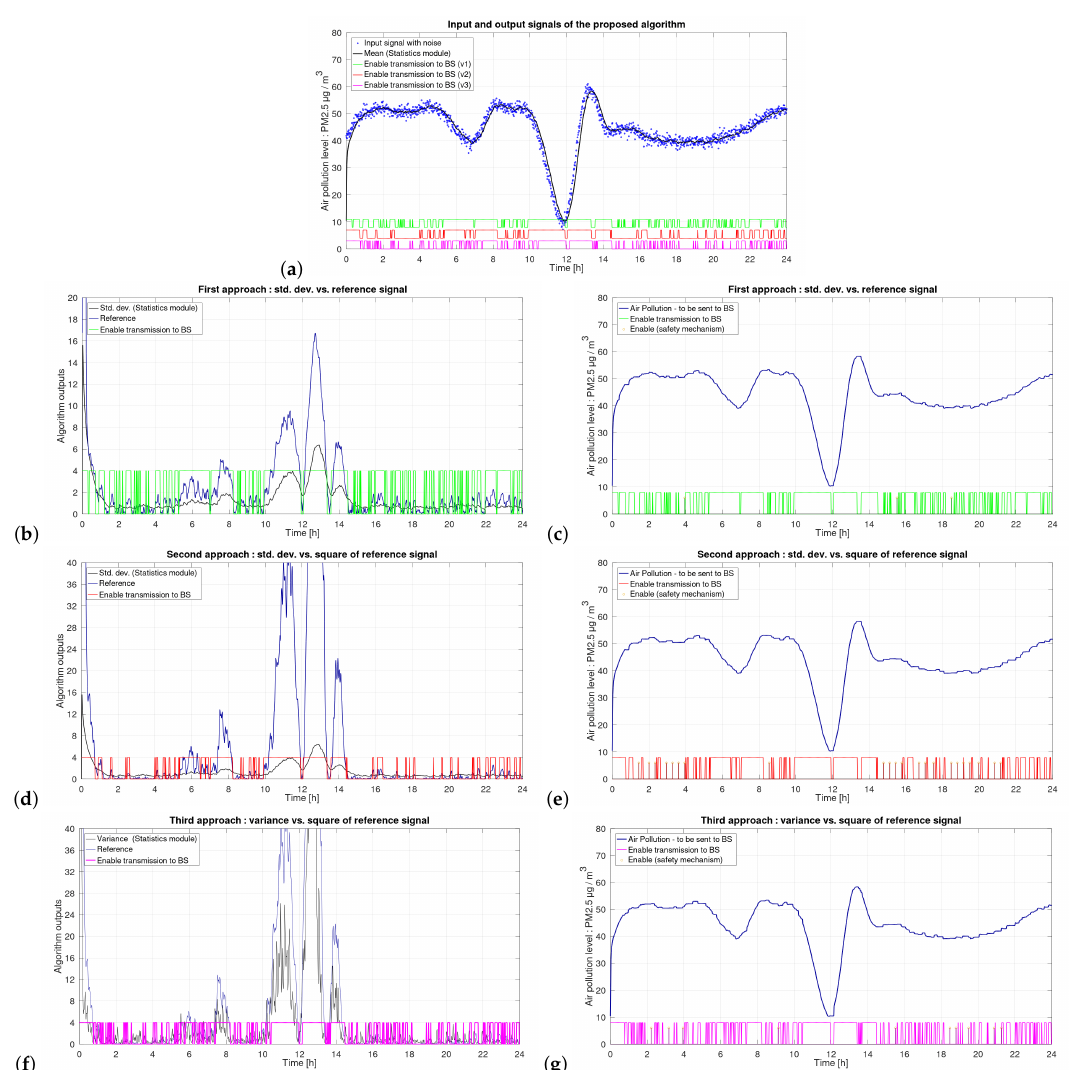
Figure 6. Simulation results of the proposed algorithm for small noise levels of c. 6 PM2.5 µ g/m 3 (10%) and the values of K and N lpf2 of 8. ( a ) Input signal with noise, corresponding mean signal, as well as transmission enable EN1, EN2 and EN3 signals, for three approaches given by Equations (7), (8) and (9), respectively; ( b ) Standard deviation, reference ( y Ref ) and EN1 signals; ( c ) Sensor output signal transmitted to the base station (BS) for approach 1; ( d ) Standard deviation, square of reference ( y 2 and EN2; ( e ) Sensor output signal transmitted to the BS for approach 2; ( f ) Variance, square of reference ( y 2 ) and EN3 signals; ( g ) Sensor output signal transmitted to the BS for approach Ref